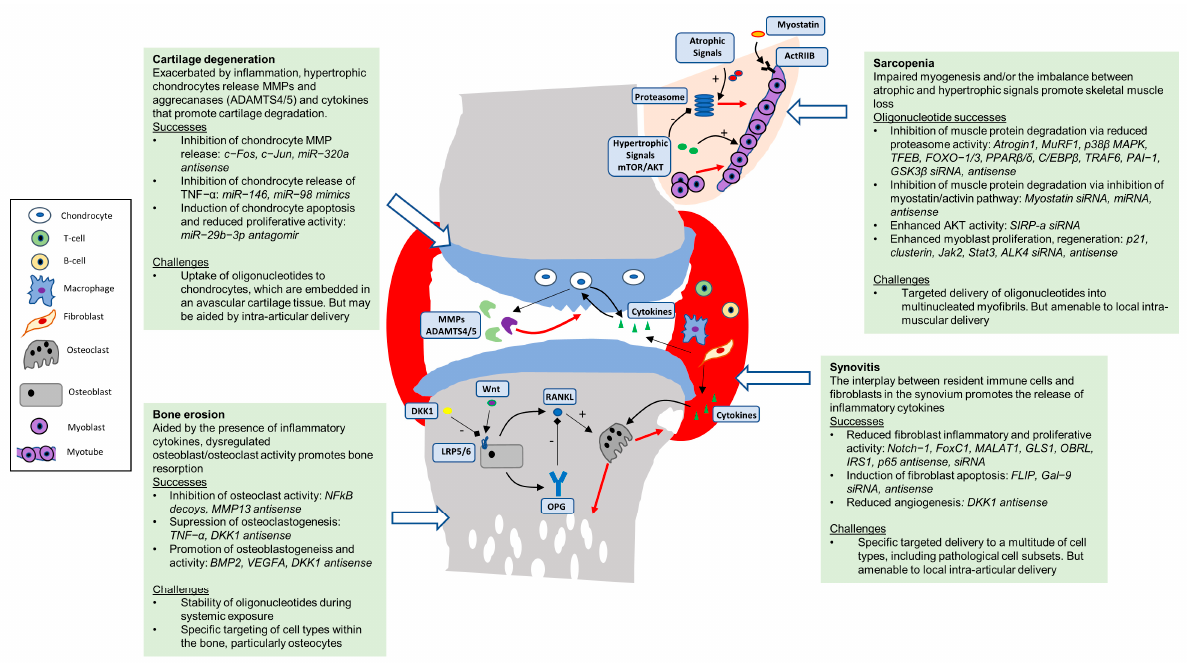
Figure 1. Oligonucleotides targeting pathological cellular processes in the tissues of the musculosketal system. ADAMTS 4, 5; a disintegrin and metalloproteinase with thrombospondin motifs 4, 5. BMP; bone morphogenic protein. DKK1; Dickkopf-elated protein 1. FOXC1; forkhead box C1. MMP; matrix metalloproteinase. OPG; osteoprotegerin. RANKL; receptor activator of nuclear factor kappa-B ligand. TNF- α ; tumour necrosis factor. Gal-9; Galectin9. MALAT1; Metastasis Associated Lung Adenocarcinoma Transcript 1. GLS1; Glutaminase-1. OBRL; Long leptin receptor. PAI-1; plasminogen activator inhibitor-1. TFEB; transcription factor EB. IRS-1; insulin receptor substrate-1. SIRP- α ; signal regulatory protein alpha. C/EBP β ; CCAAT/enhancer-binding protein beta.